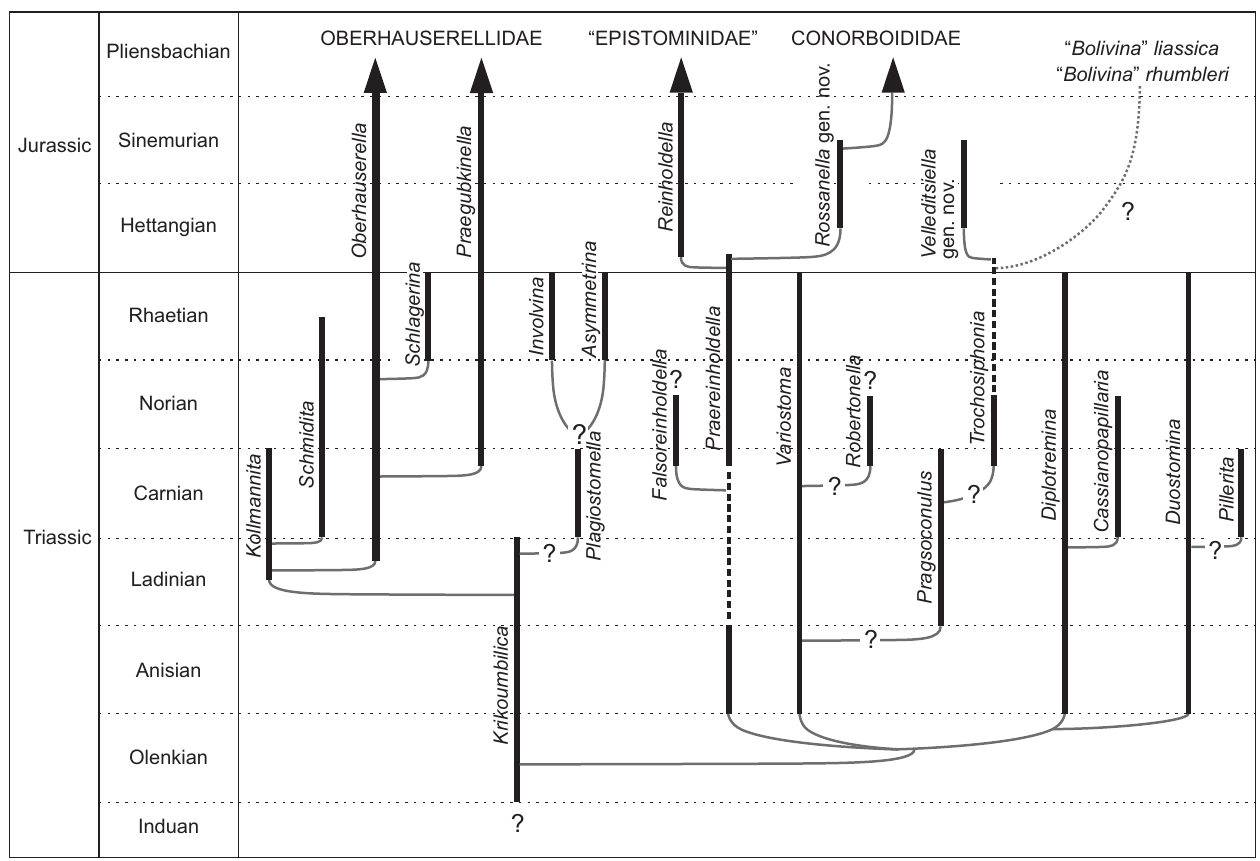
Fig. 5. Triassic–Early Jurassic evolution of the order Robertinida at the genus level (partly based on Rigaud et al. 2015b, with new data). Dashed lines indicate uncertain stratigraphic distribution, dotted lines indicate uncertain phyletic